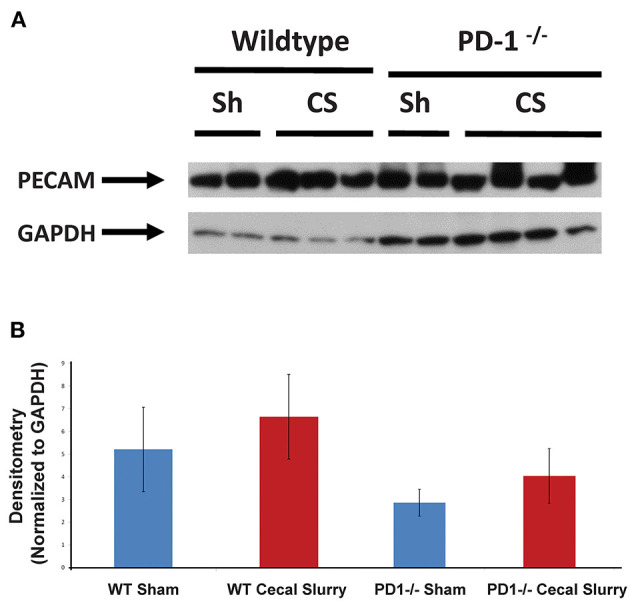
PECAM-1 expression in the lung. Western blot analysis (a representative blot provided) (A) showed no significant difference among the groups in terms of PECAM-1 expression [(B), provide summary data of repeat assessments of PECAM-1 expression as a ratioed to the housekeeping gene GAPDHs' expression]. Mean ± SEM, n = 6–9 per group; P >0.05 vs. Sham group; ANOVA with Holm–Sidak post-hoc analysis.